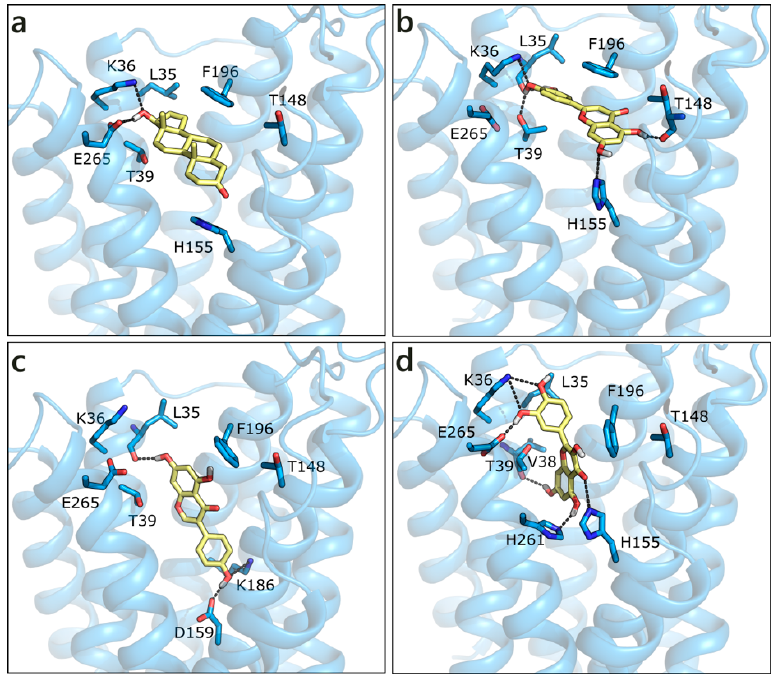
Figure 8. Docking poses of T ( a ), LUT ( b ), GEN ( c ), and QRC ( d ) in the ZIP9 model. The protein is shown in transparent light blue cartoon, the residues lining the binding site and the ligands are shown in capped sticks and colored light blue and yellow, respectively. Helices and residues lining the pocket are labelled, hydrogen bonds are displayed as black dashed lines.